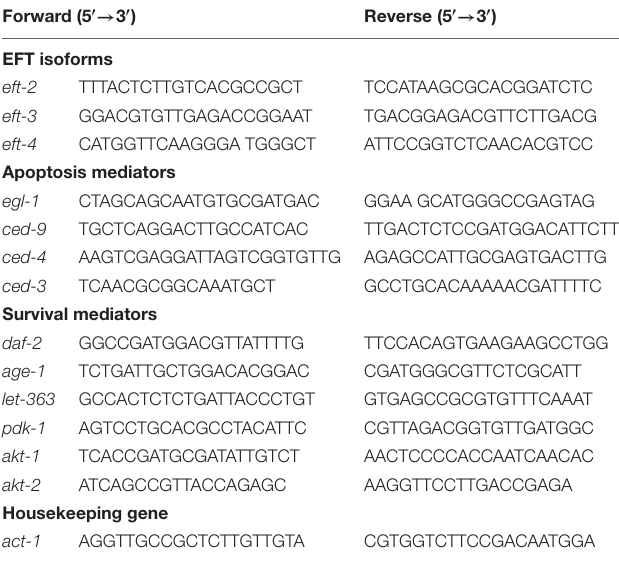
TABLE 1 | Primer lists used in this